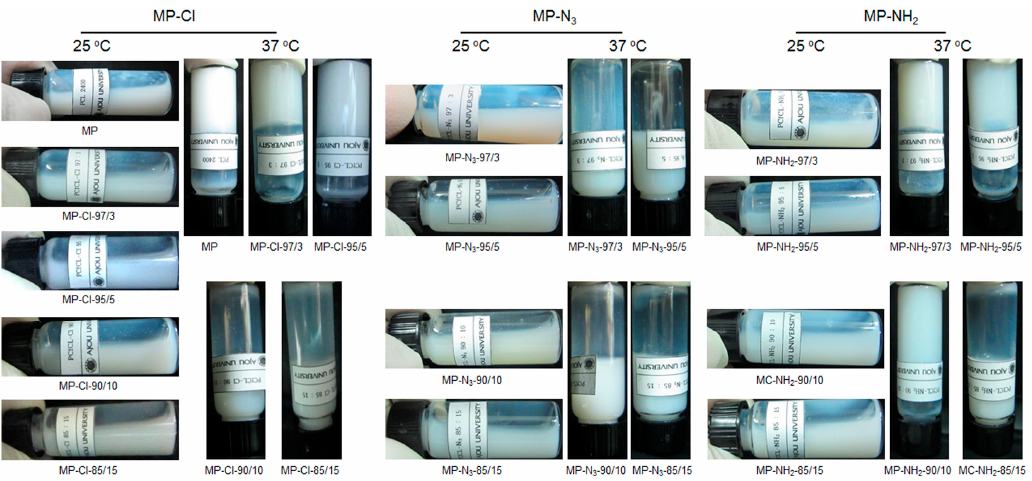
Figure 5. Images of MP-Cl, MP-N 3 , and MP-NH 2 diblock copolymer solutions with 3–15 mol % chloride, azide and amine pendant groups at 25 and 37 °C.